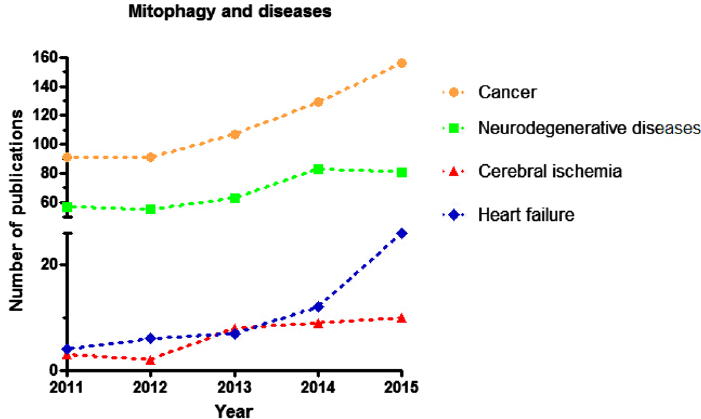
Figure 1. Trends in research on mitophagy in human disease. Summary of the study trends of mitophagy and its related human disease from 2011 to